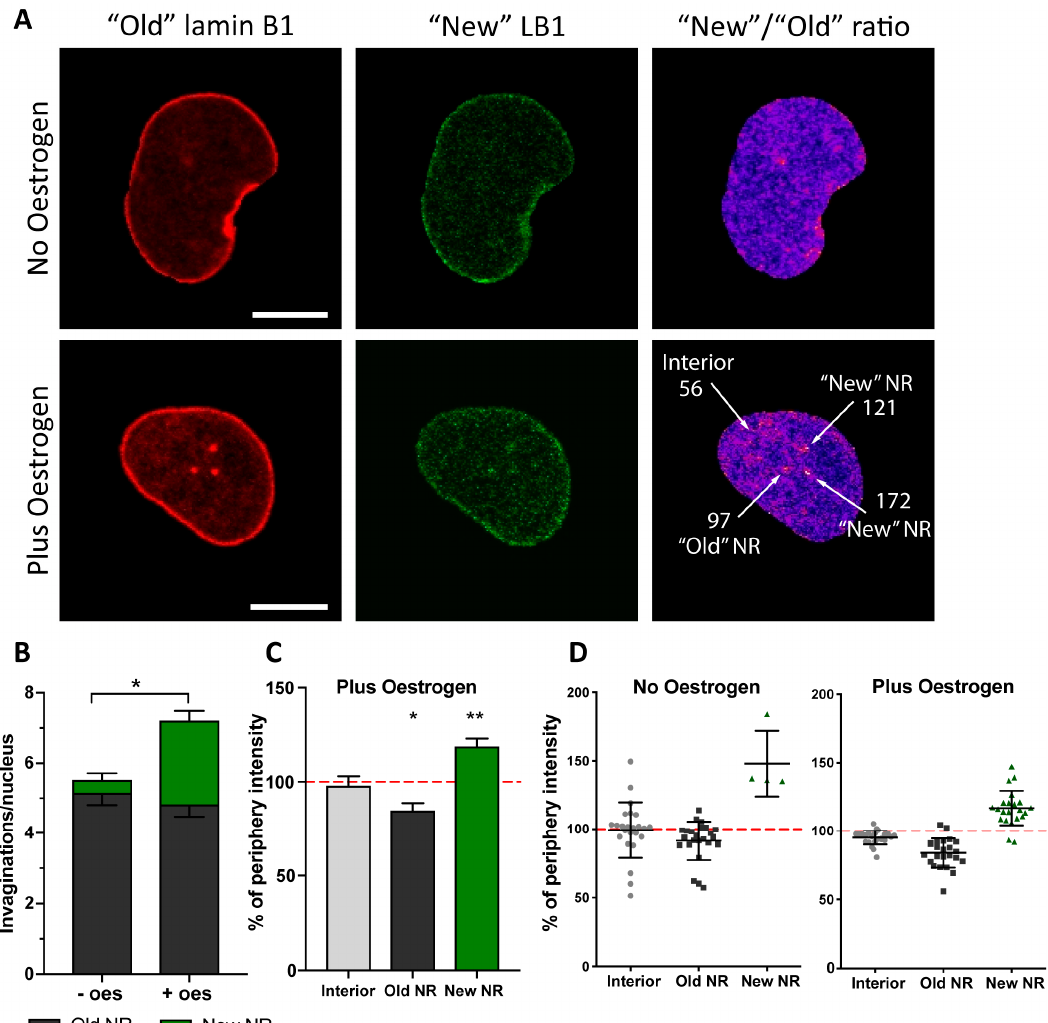
Figure 4. Nascent lamin B1 is incorporated in newly formed invaginations. ( A ) Confocal microscopy of Ishikawa cells expressing lamin B1- Maple3. Indicated are the “old” (red channel) and “new” (green channel) lamin protein pools. Ratiometric image of “New” / ”Old” is provided with indication of ratio values for selected ROIs around the features arrowed. ( B ) Evaluation of invagination abundance per nucleus in Ishikawa cells with ( + oes) or without oestrogen (-oes) treatment. ( C ) Pixel intensities of the ROIs defined in based on the ratiometric images and normalised to the signal at the nuclear rim showing increased incorporation of nascent lamin B1 at the newly forming NR channels; results from three independent experiments, 35 cells in total; mean ± SD; ** p -value < 0.001; * p -value < 0.05. ( D ) An example data plot from a single experiment showing distribution of “New”/”Old” lamin B1 ratio at different nuclear structures and normalised to the nuclear rim ratio with or without oestrogen.